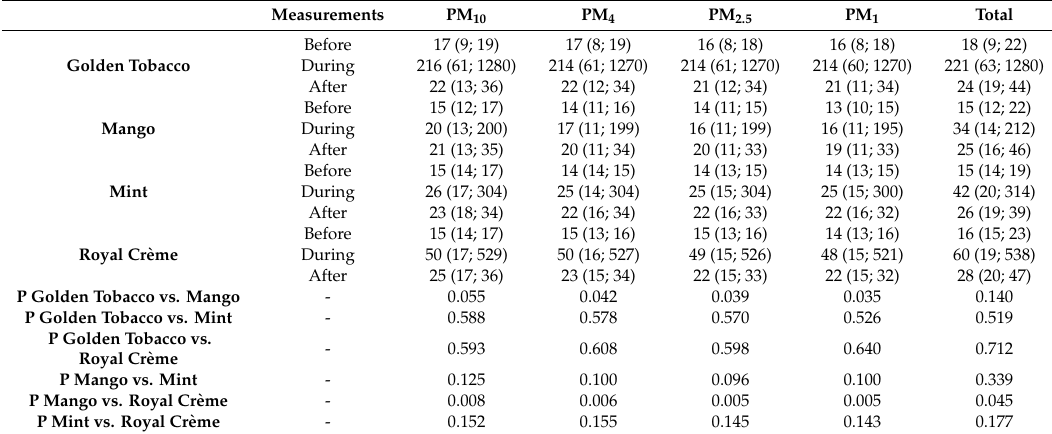
Table 4. Levels of particulate matter (PM), expressed as µ g / m 3 , comparing di ff erent flavors of Juul *.